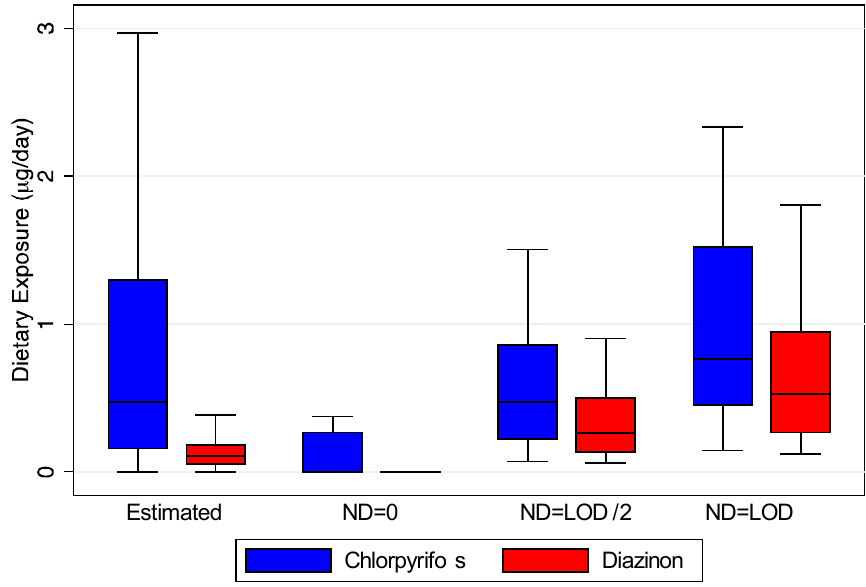
Estimated ND=0 ND=LOD /2 ND=LOD Chlorpyrifo s